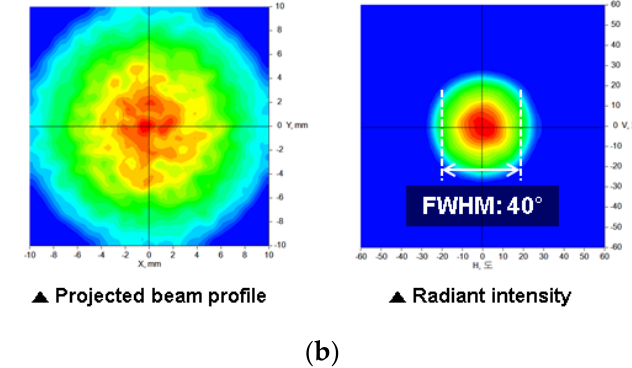
Figure 9. Simulation characteristics with limited LES optics: ( a ) ray path characteristics; ( b ) beam profile and light distribution characteristics.